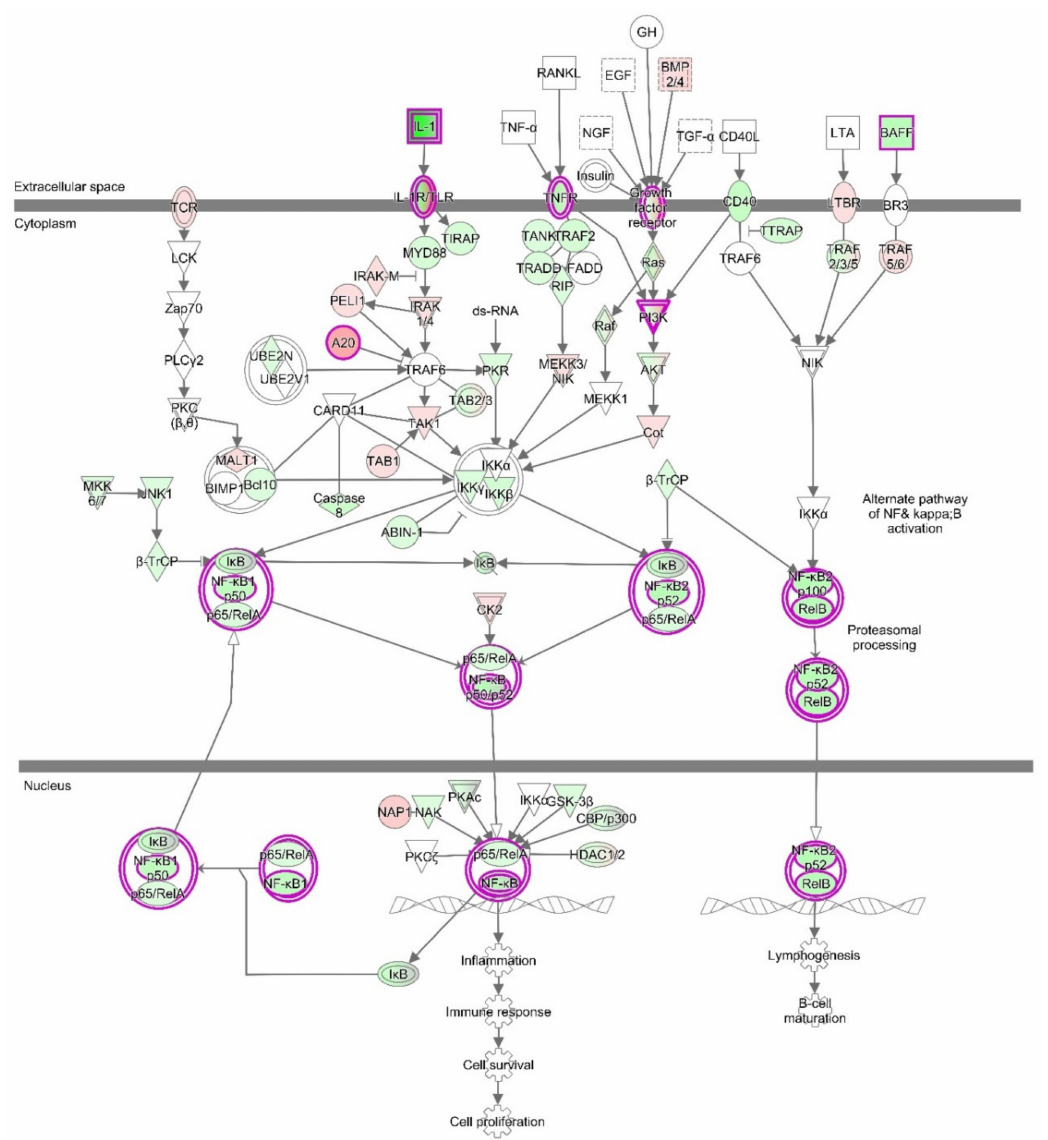
Figure 7. The canonical pathway “NF-kB Signaling” for VA vs. Ctr treatment group. This canonical pathway has a negative activation z-score ( p -value = 4.25 × 10 − 4 , z-score = − 0.5, tendency for inhibition). Red fillings = “activated”, green fillings = “inhibited”, purple highlights = passed cut-o ff s, no highlight = did not pass cut-o ff